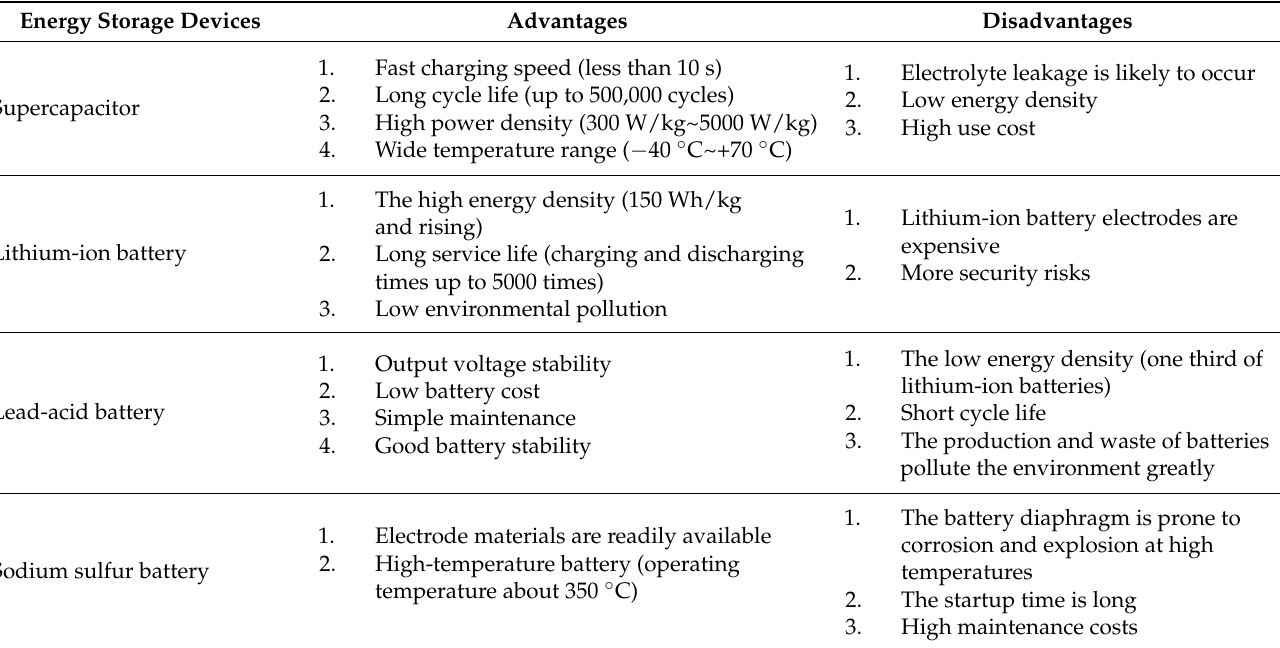
Table 1. Performance comparison between supercapacitors and